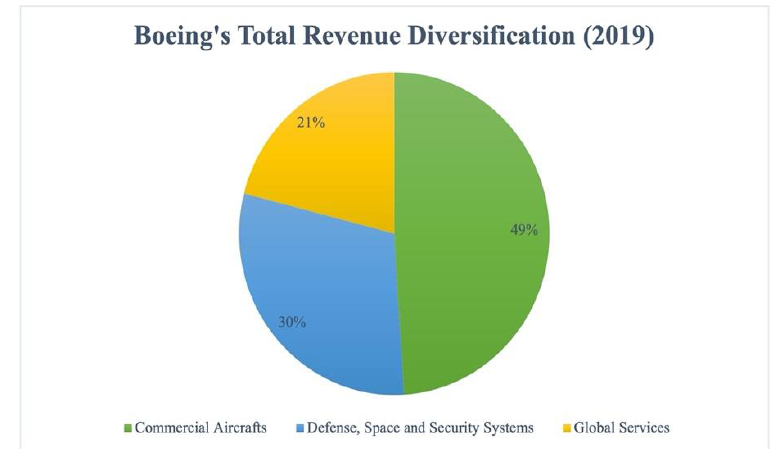
Figure 1. Airbus ’s total revenue diversification. Source: Forbes (2019).